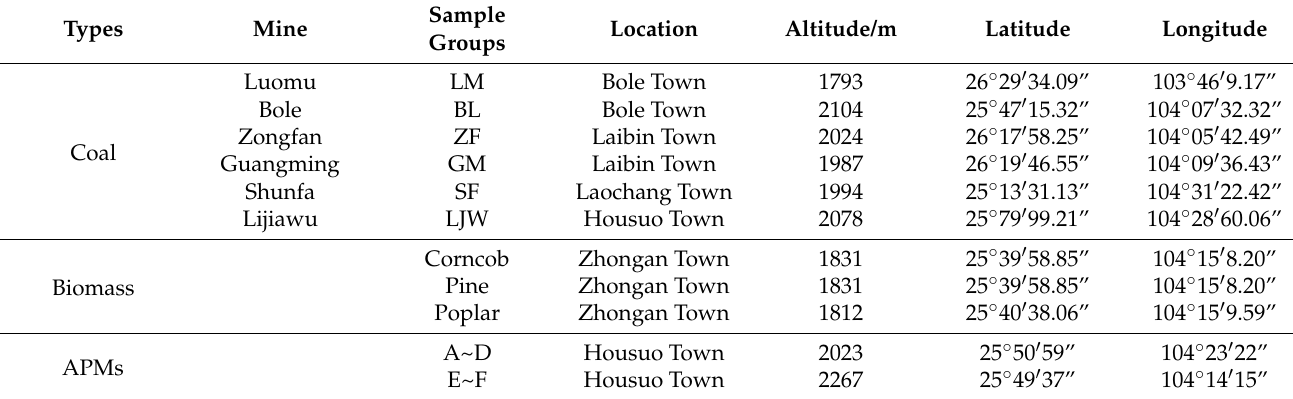
Table 1. The detail information of raw coal, biomass and APMs from